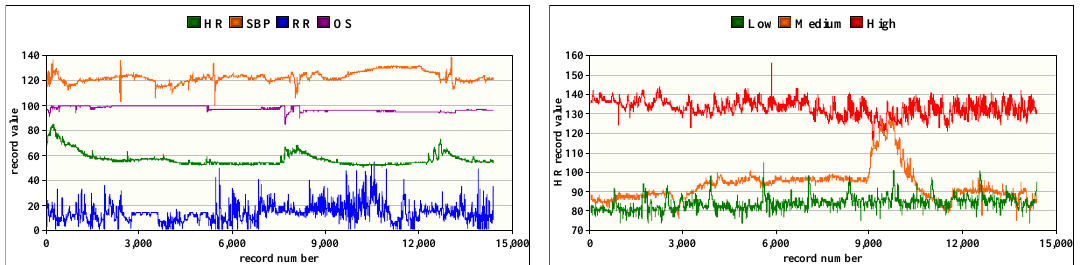
Figure 4. Variation of raw record data during 4 h of patient monitoring.